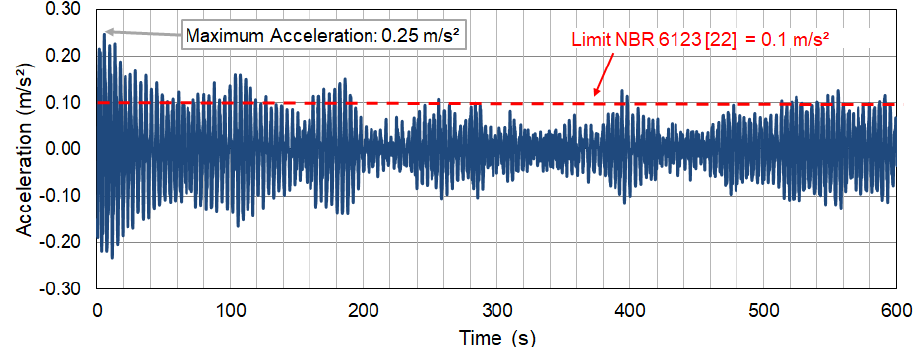
Figure 12. Example of acceleration result at 87 meters high (period of recurrence of 10 years).